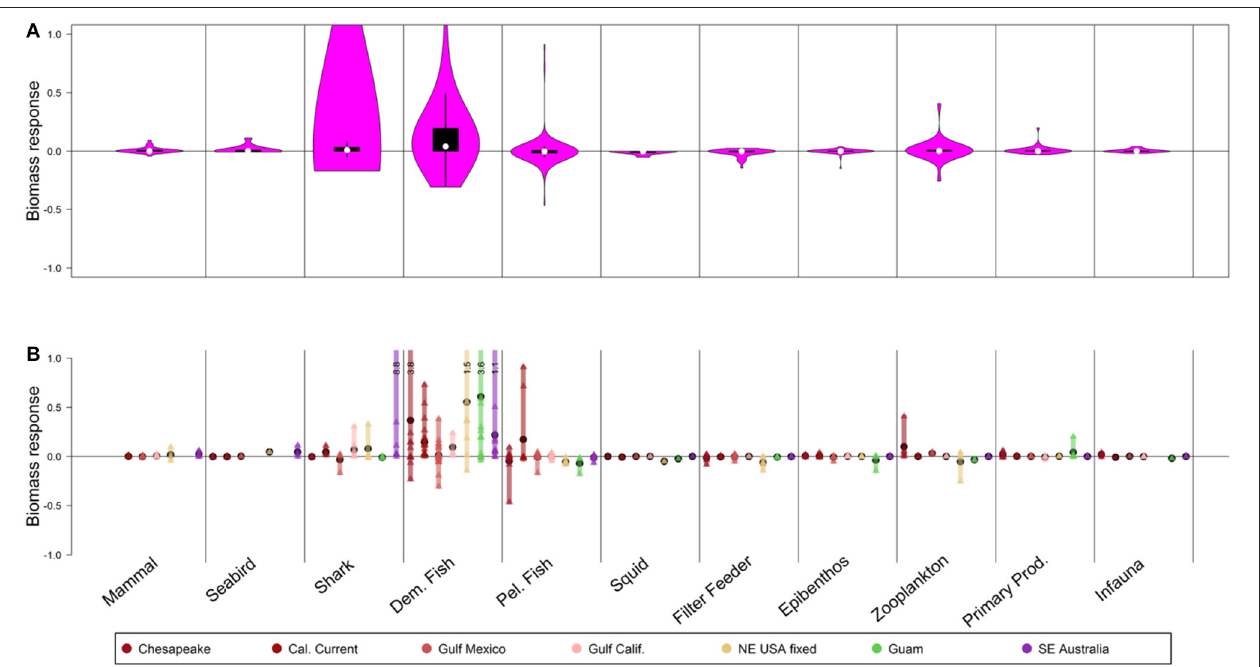
FIGURE 6 | Biomass response to 50-year scenarios with 0.5 × fishing mortality on demersal fish. Panel explanations as in Figure 2 .